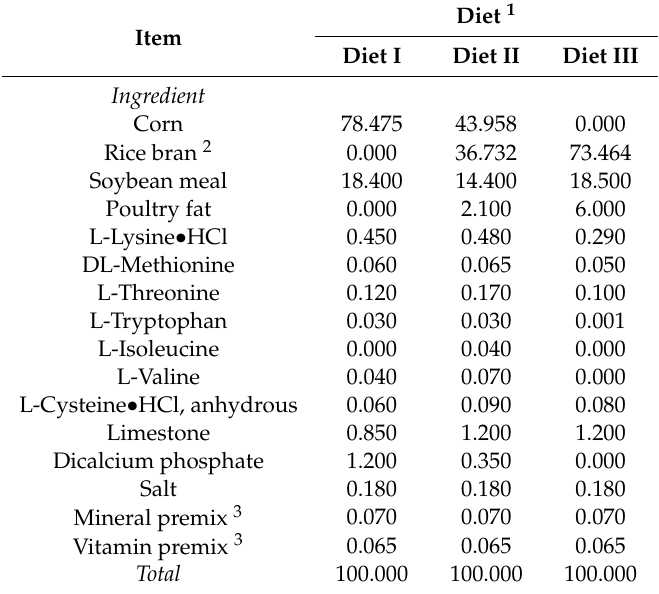
Table 1. Composition (%, as-fed basis) of the three experimental diets formulated for the growing pigs.